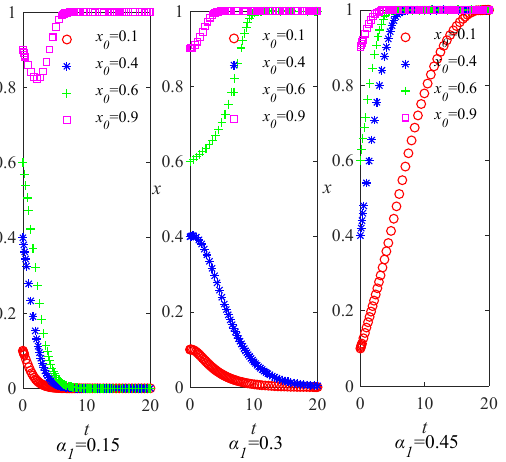
Figure 10. The impact of government subsidy to construction enterprises on system evolution results.